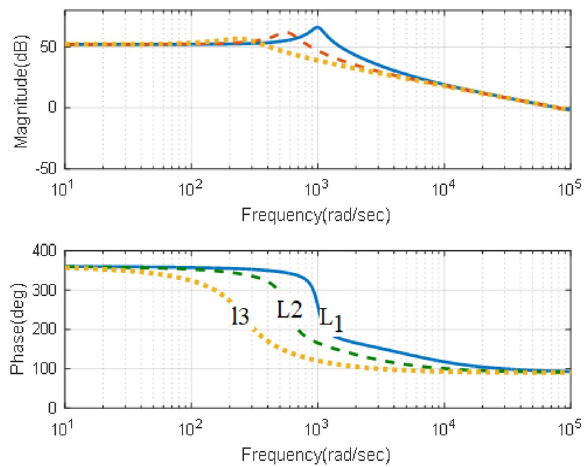
Figure 3. Effects of varying the inductance,